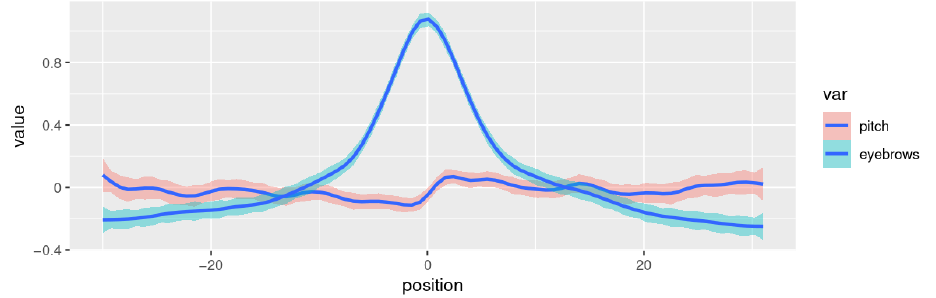
Figure 5. Smoothed curves showing the eyebrow height (blue) and pitch value (red) of the speaker sample, with 95% confidence intervals for the standard errors. The smoothing curves show a generalized additive model fitted to the data (k = 30).